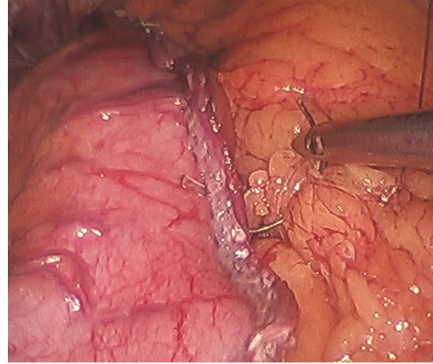
Figure 5: Suturing omentum back to sleeve staple